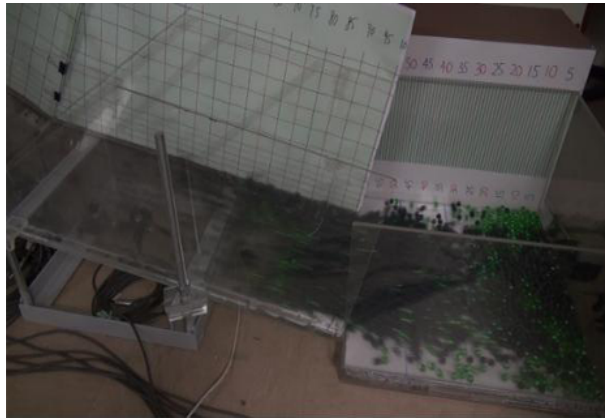
Figure 5. Flume model with a small jump in the laboratory.